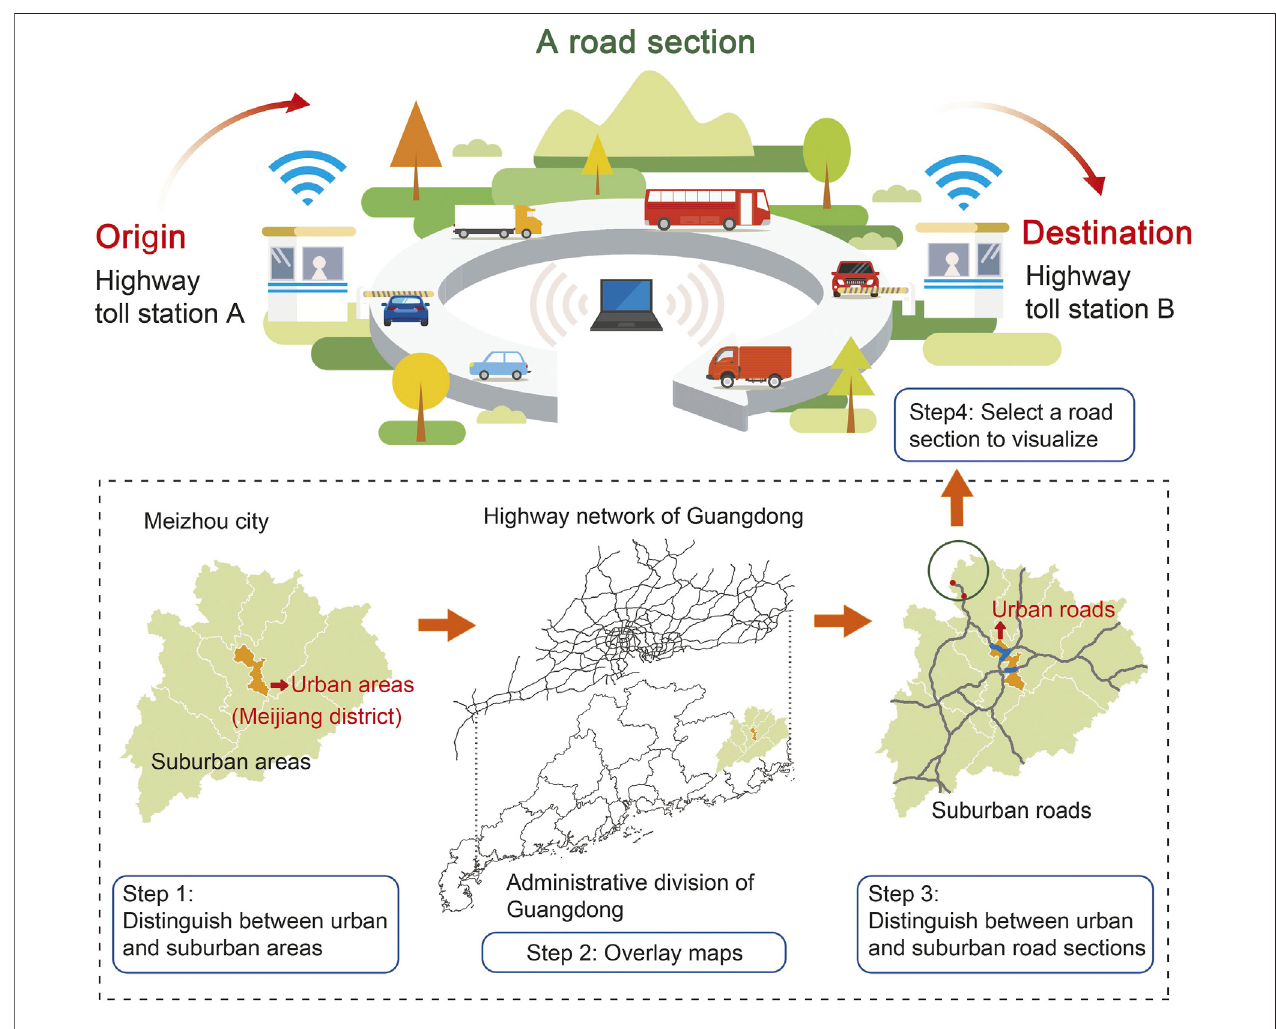
FIGURE 3 | Schematic diagram of mobile data spatial matching.